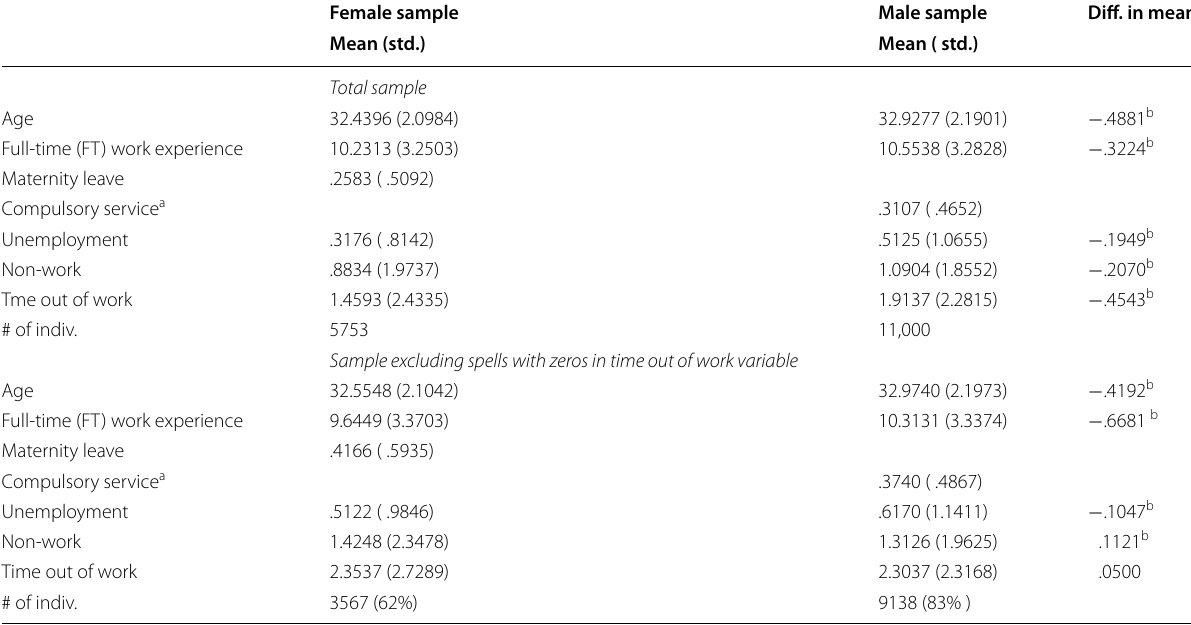
Table 1 Summary statistics for early